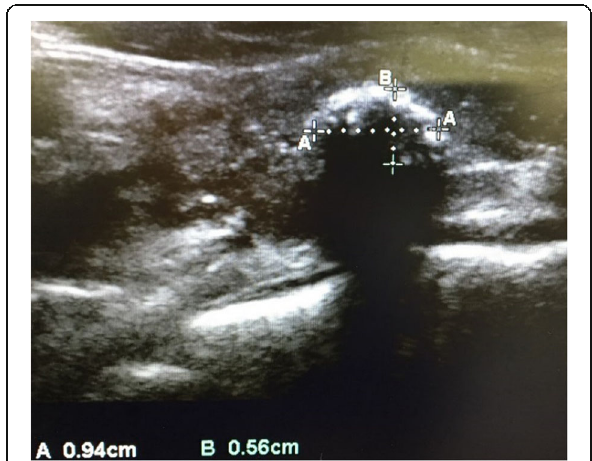
Fig. 3 Ultrasonography of the thyroid. A mass with a calcification